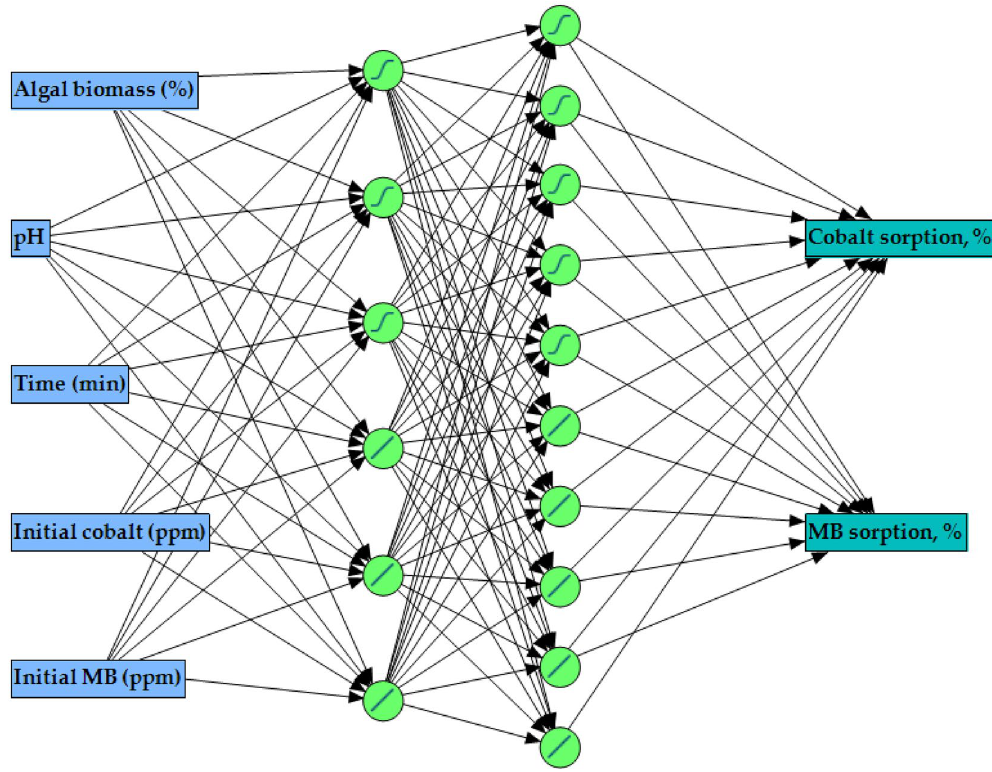
Figure 3. The general layout of the generated artificial neural network for cobalt and MB biosorption by Sargassum latifolium , shows an input layer with five neurons, the two hidden layers with 10 and 6 neurons, having a hybrid of hyperbolic tangent sigmoid function ( S ) and linear function (/), and an output layer with two neurons (responses).